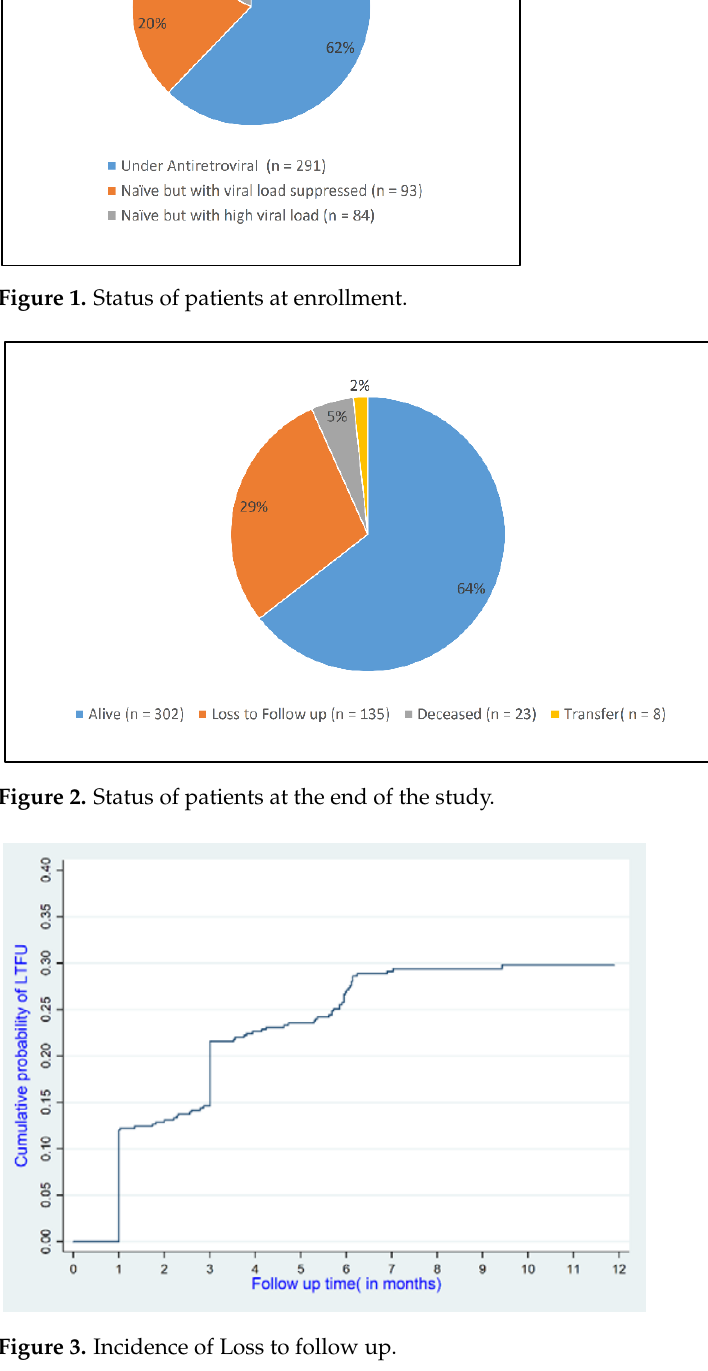
Figure 3. Incidence of Loss to follow up.